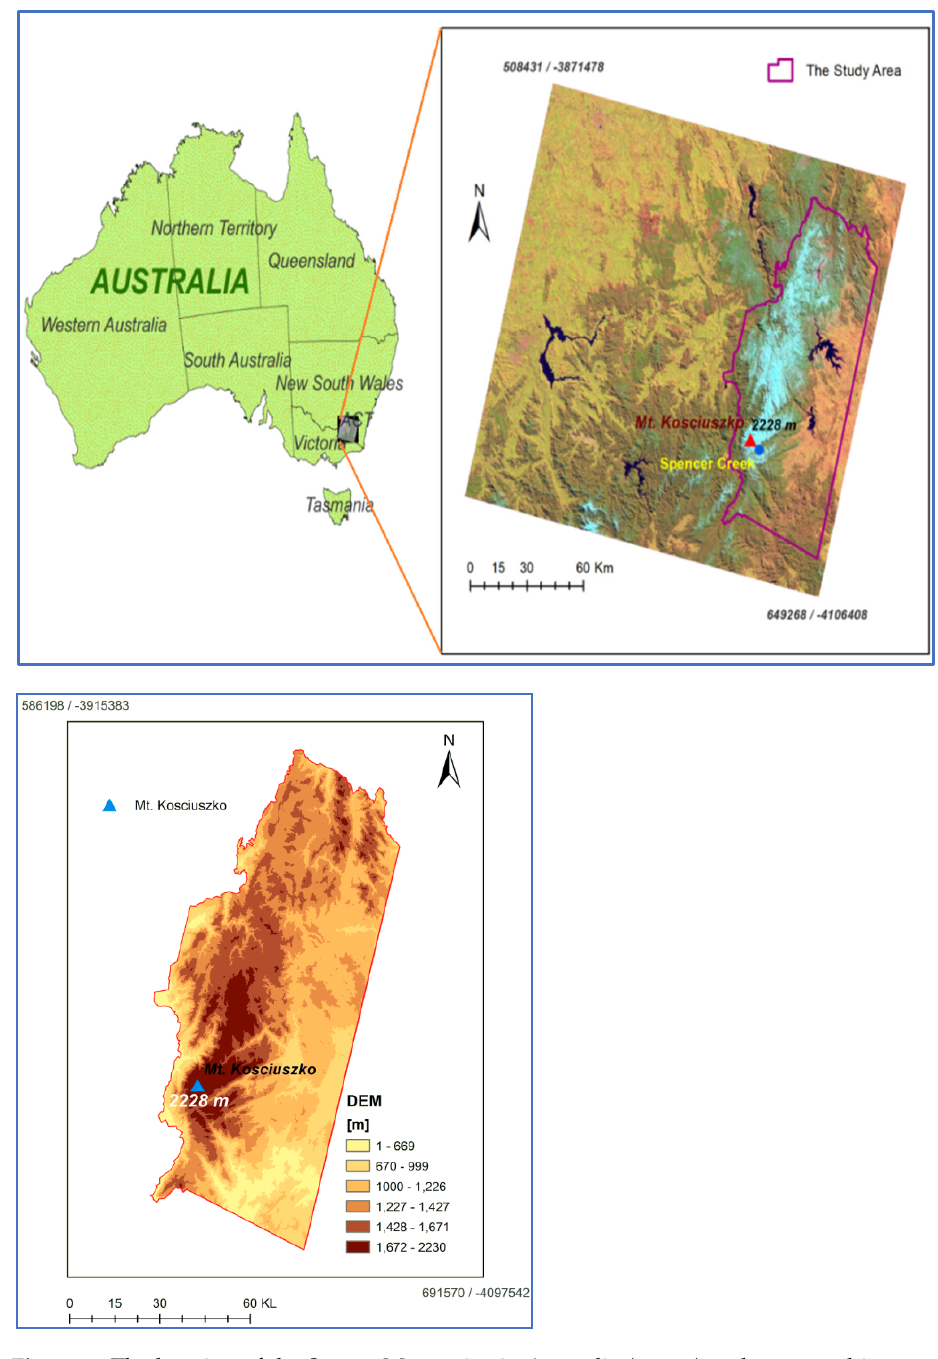
Figure 1. The location of the Snowy Mountains in Australia ( upper ) and topographic map of the study area ( lower ).